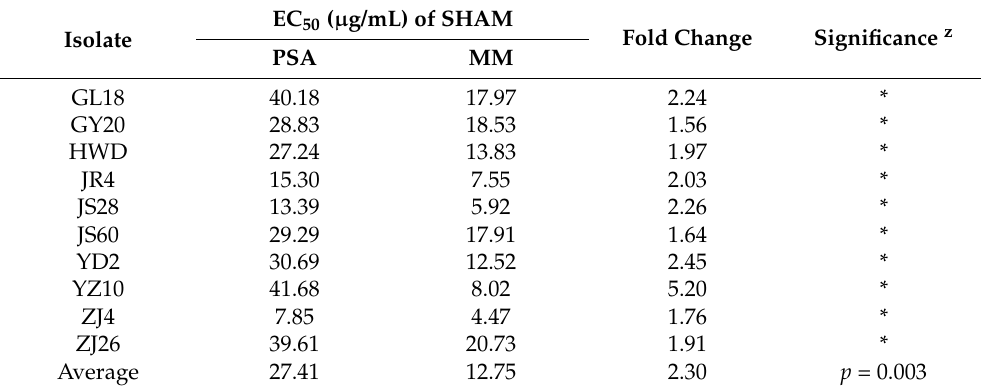
z T test was used to compare the differences in EC 50 of SHAM between on PSA and on MM. An asterisk (*) indicates that there is a significant difference ( p < 0.05) for isolate between on PSA and MM by t test.